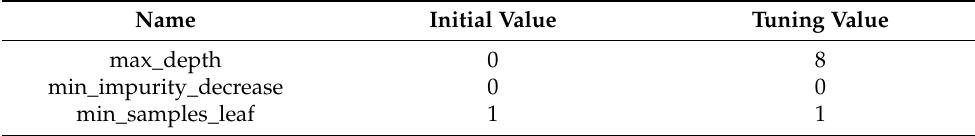
Table 10. DT algorithm tuning results.